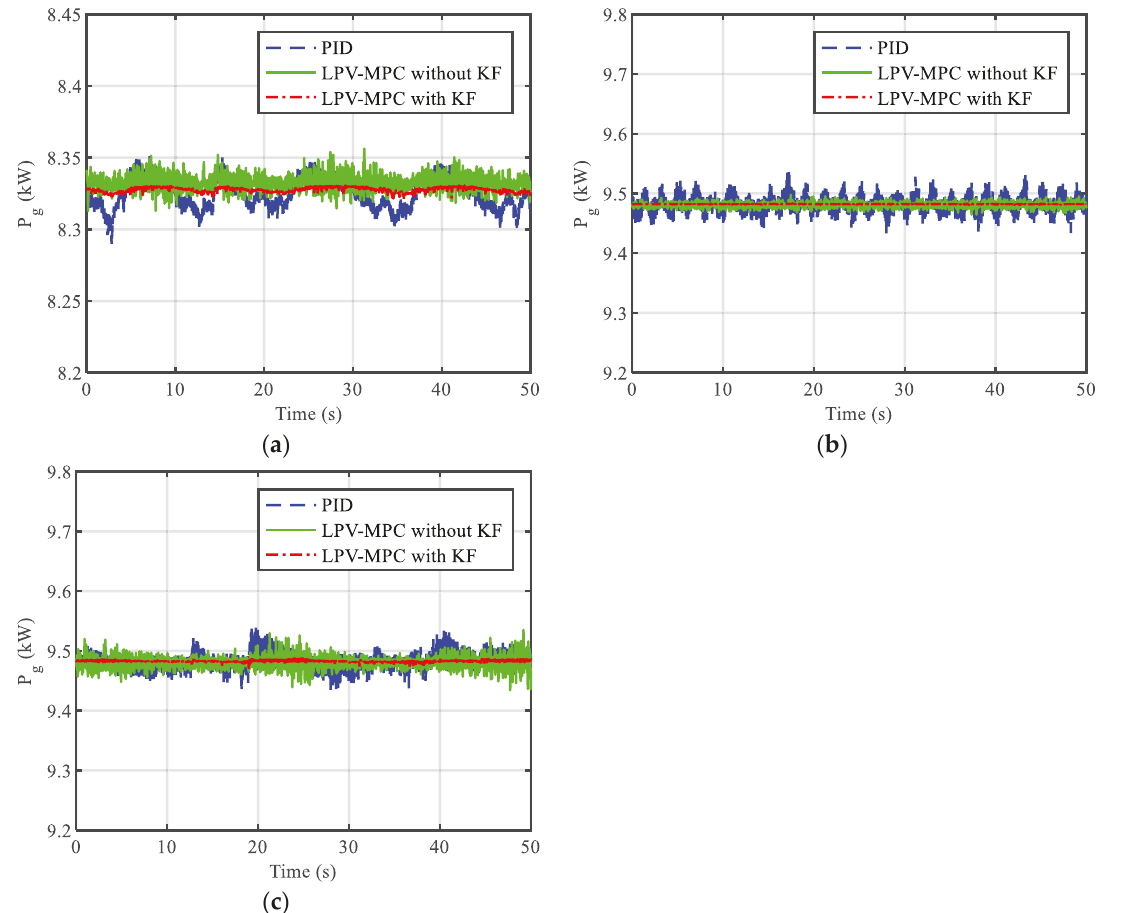
Figure 7. Comparison of generator power under different control methods: ( a ) scenario 1; ( b ) scenario 2; ( c ) scenario 3.